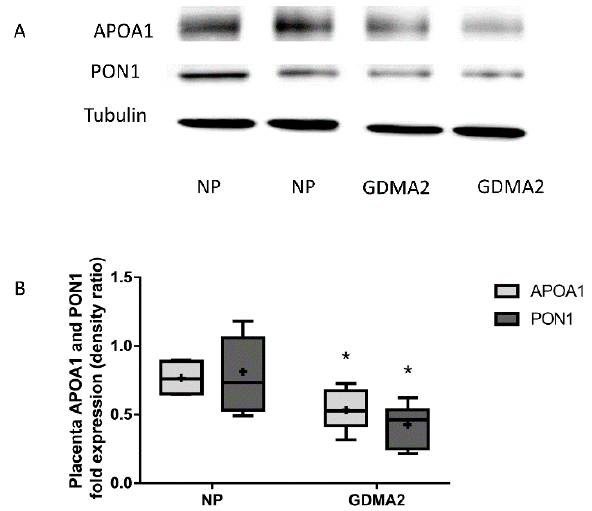
Figure 2. APOA1 and PON1 protein expression in placental tissue. ( A ) Protein extracted from placenta tissue run on 10% PAGE-SDS followed by western blot analysis using anti-APOA1, anti- PON1 antibodies and Tubulin ( B ) APOA1 and PON1 protein expression (densitometric analysis). Optical densities were normalized to Tubulin. Data are expressed as mean ± SD of 10 NP placenta and 20 GDMA2 placenta tissues. * p < 0.05 compared to NP. PAGE-SDS represents two independent experiments of NP and GDMA2, each. Box plots show the five-number summary of a set of data, including the minimum score, first (lower) quartile, median, third (upper) quartile, and maximum score, “+” indicates the average.